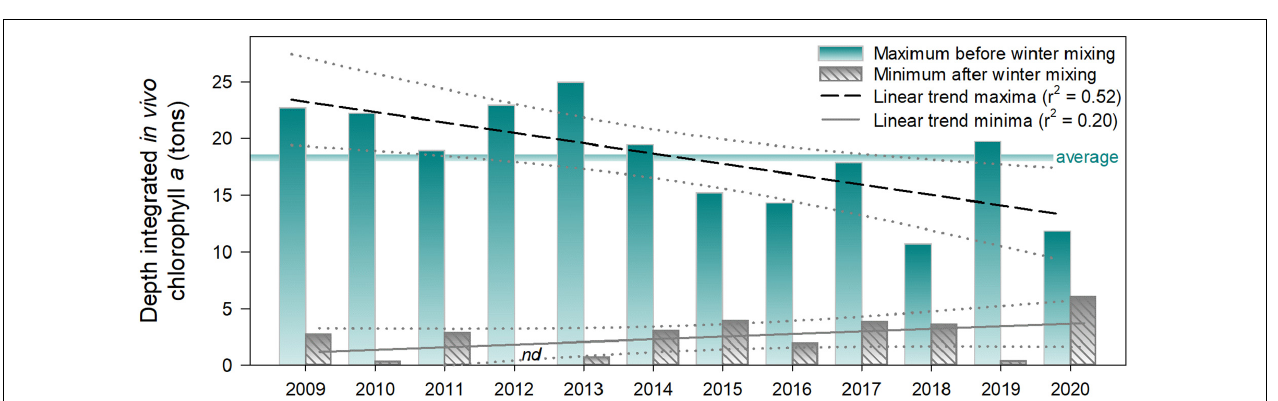
FIGURE 3 | Total population dynamics and vertical distribution of the cyanobacterium P. rubescens in Lake Zurich from 2009 to 2020 based on in vivo chlorophyll a concentrations. (A) Cumulative population size (in metric tons chlorophyll a ) shown in 20 m layers (for the zone of 0–120 m) to highlight the entrainment of filaments into the deep zone during winter mixing. (B) Data as in (A) but as percentages on the total chlorophyll a mass. (C) Ratios (0–1) of the surviving population after deep winter mixing to the former maximum population (max = 1; black lines and dots) and ratios of this surviving population to the following maximum population (max = 1; green lines and dots).